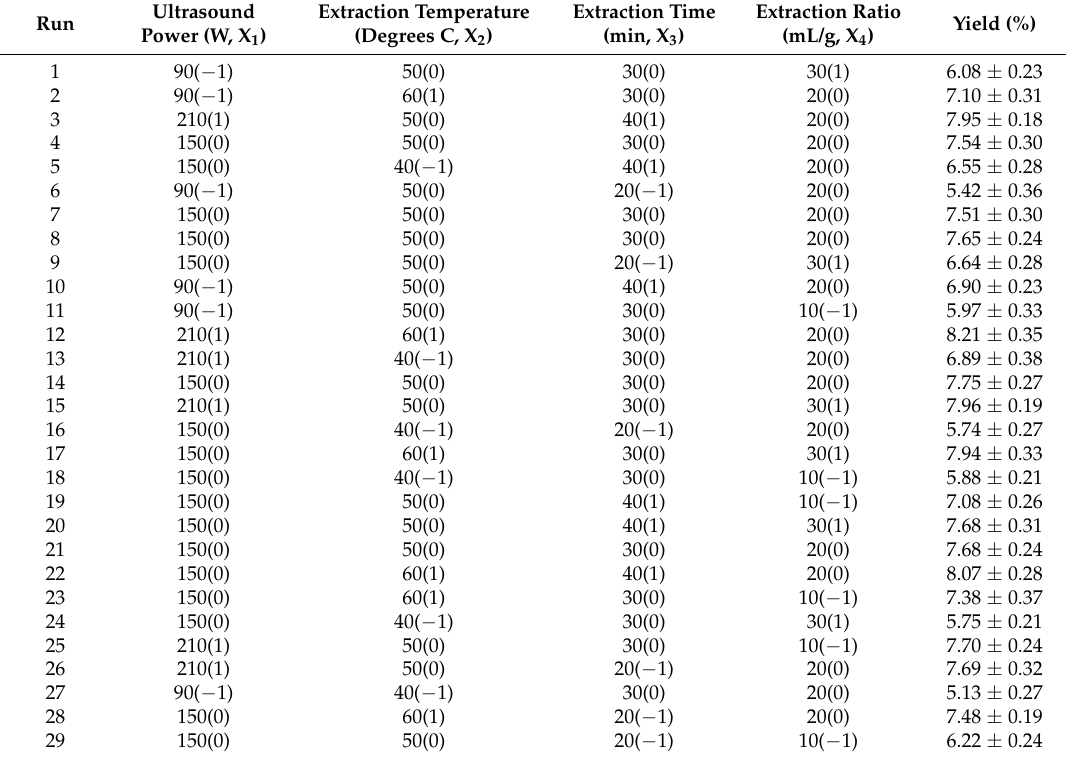
Table 1. Coded and levels of independent variables and the response used in Box-Behnken design